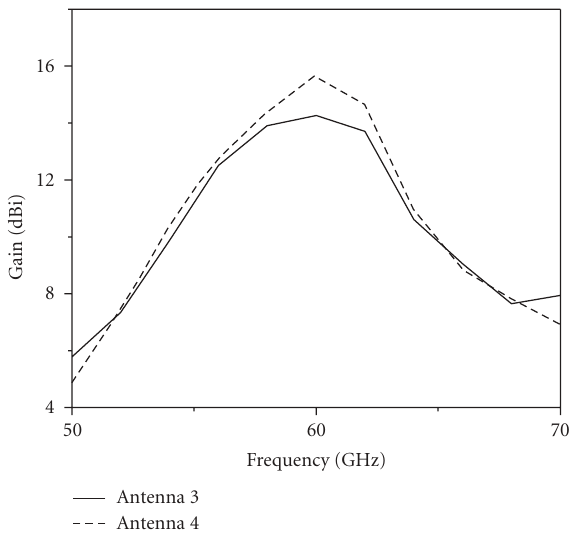
Figure 7: Realized gain for antenna 3 and antenna 4.